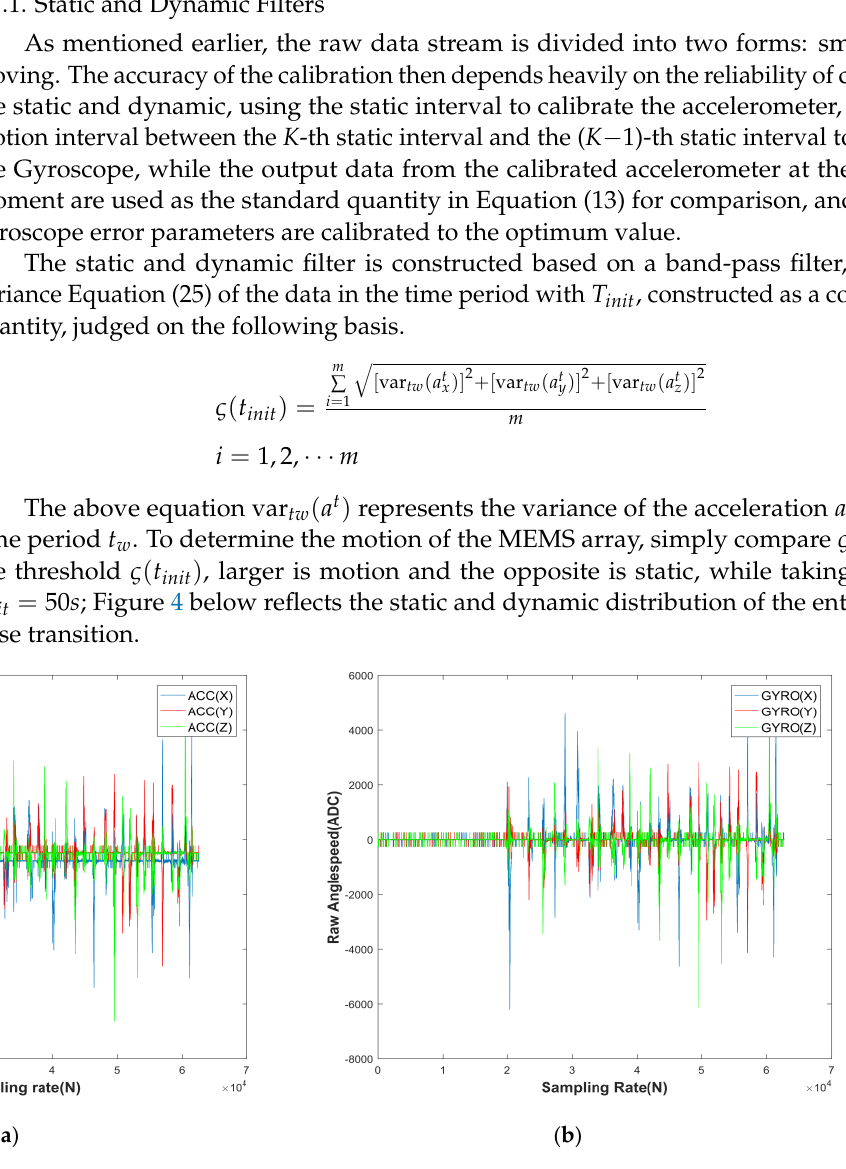
Figure 4. Static and dynamic distribution of accelerometers and gyroscopes: ( a ) dynamic distribution of accelerometers; ( b ) dynamic distribution of accelerometers.